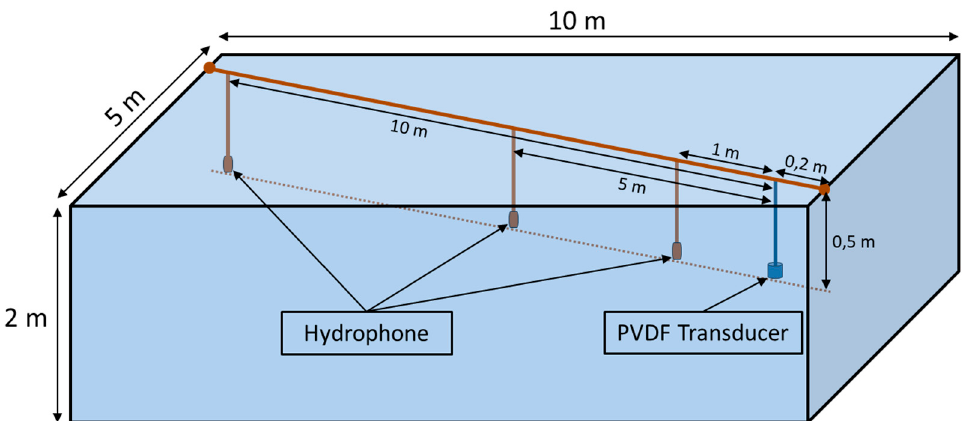
Figure 6. Experimental setup diagram used for measuring the Transmission Voltage Response and the Spread Angle Response. The transducer was tested in a freshwater pool with 10 m long, 5 m wide and 2 m deep with an average temperature of 21 °C.